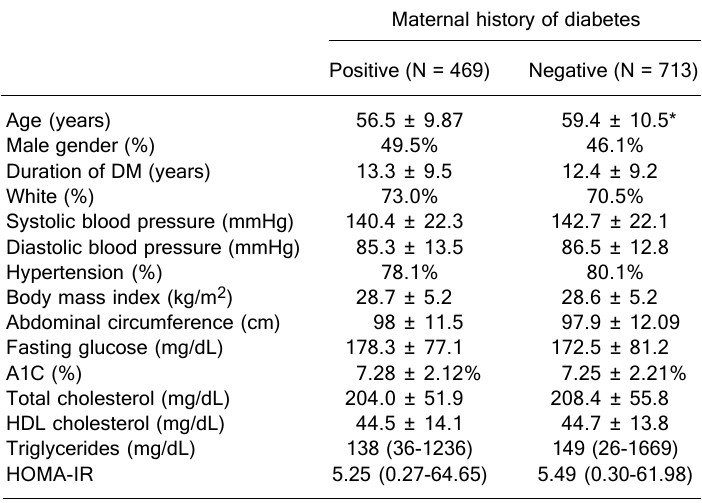
Table 1. Clinical and laboratory characteristics of patients with or without maternal diabetes mellitus